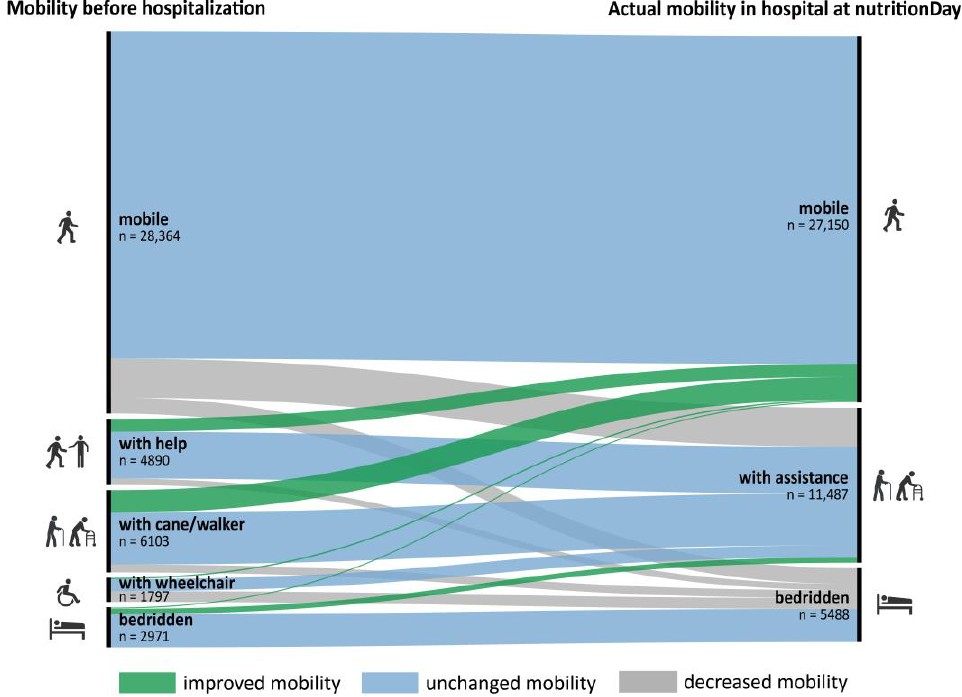
Figure 1. Mobility before hospital admission versus actual mobility at nutritionDay ( n = 44,125), category “missing” is excluded from the graph.